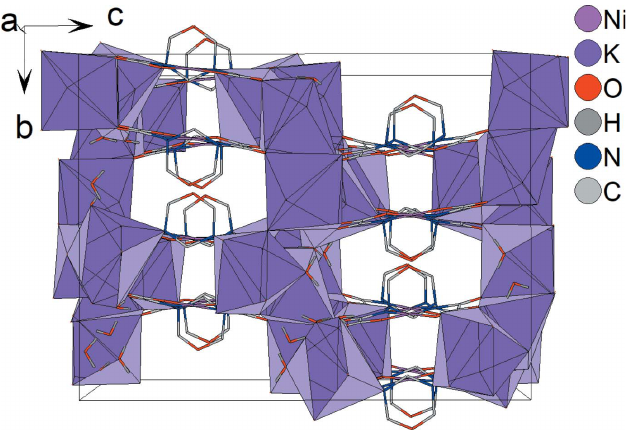
Figure 5 Crystal packing of the title compound in a stick model, showing the coordination polyhedra of the potassium cations in lilac. H atoms of the C—H groups and minor disordered components (K3 A and K4 B , O4 WB water molecule) are omitted for clarity.